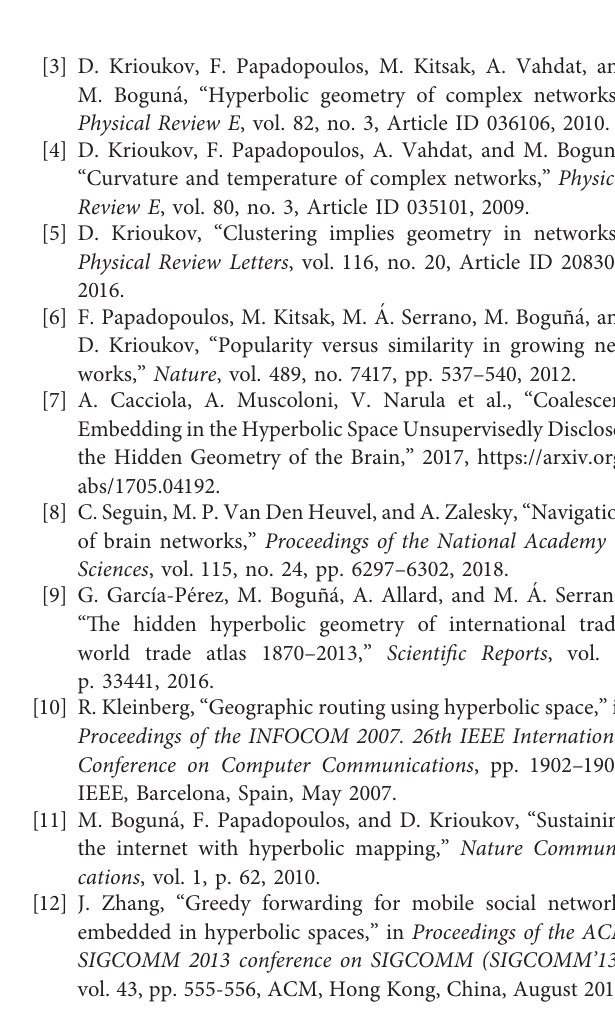
) are set as 3.5. The model ∗